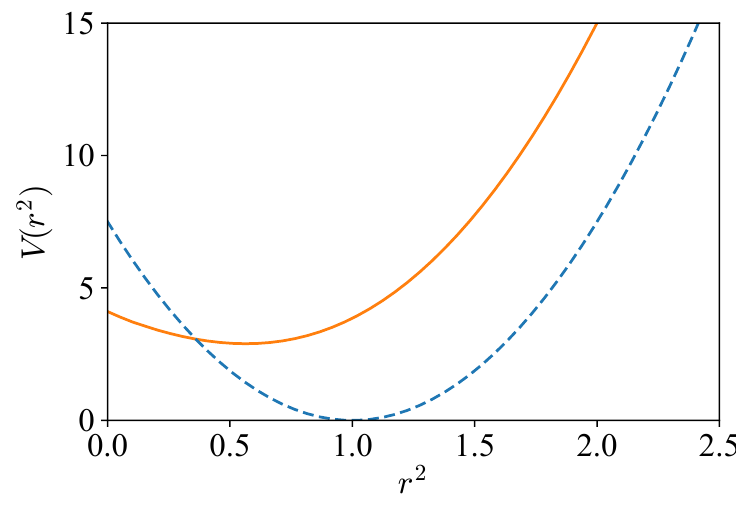
Figure 6 . Effective potential at θ = 3 π evolved to k ’ 2 . 944 where the evolution stops. The dotted curve represents the initial effective potential as shown in figure